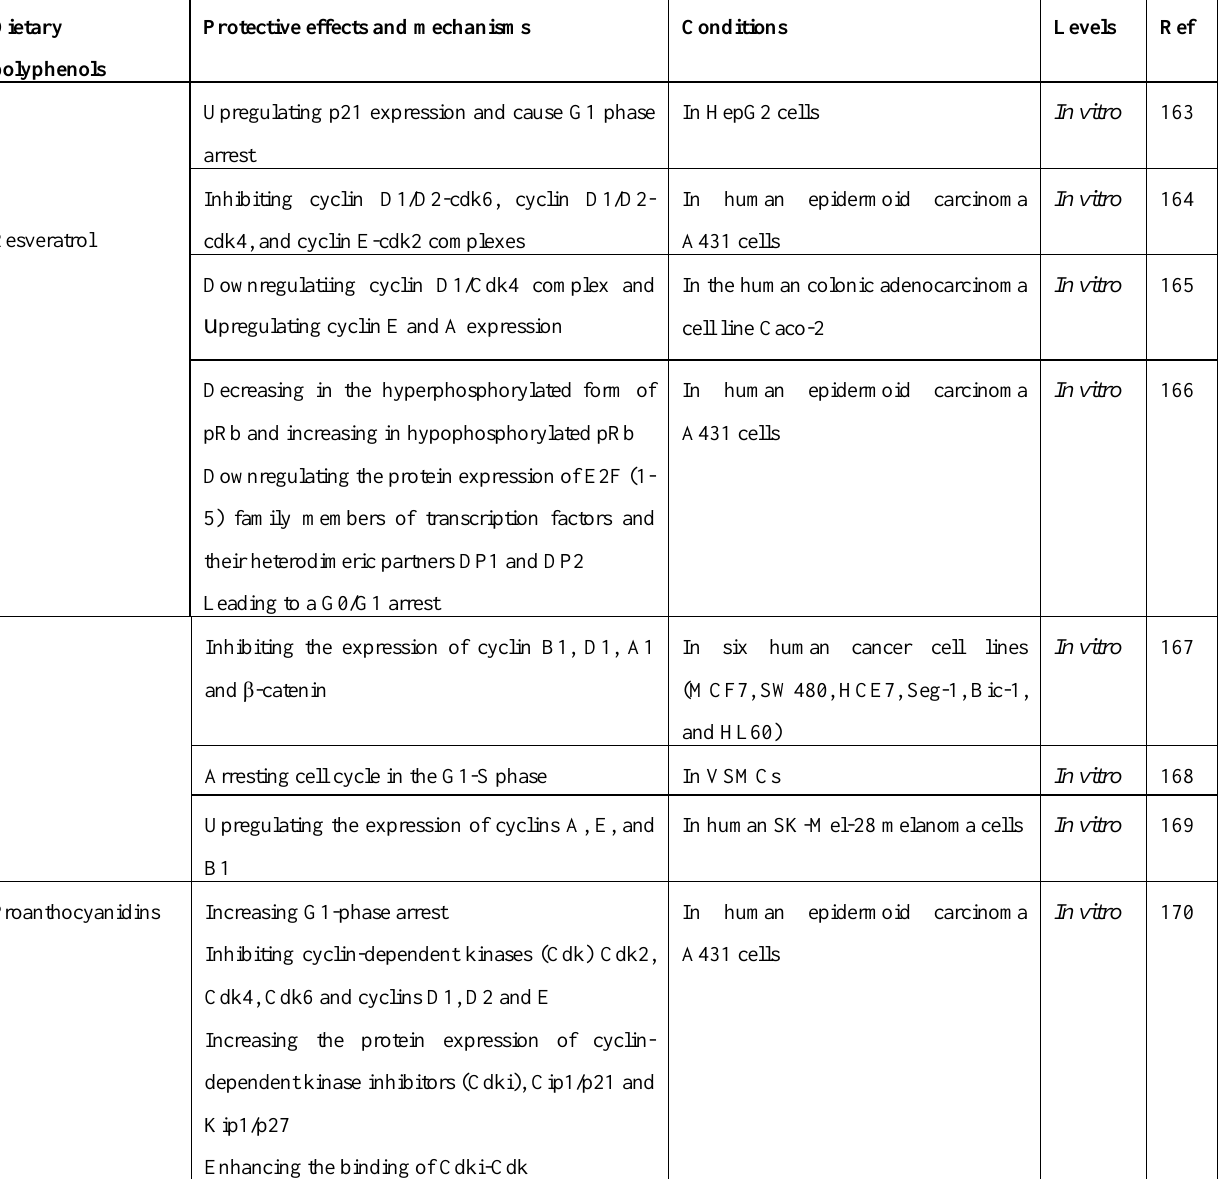
Table 10. Regulate cell cycle progression of dietary